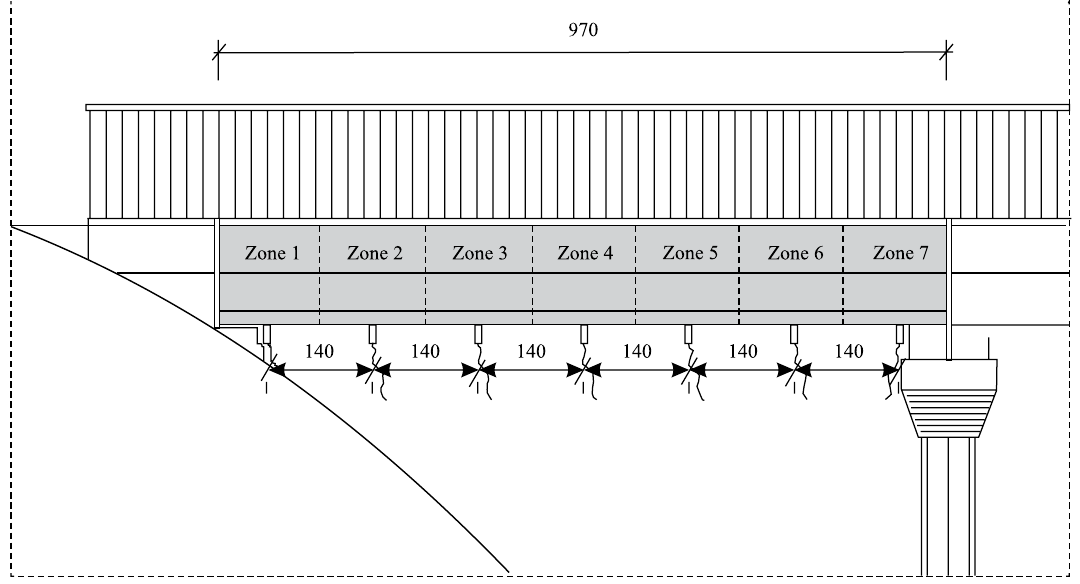
Fig. 6. The structure under consideration and arrangement of the AE sensors along one of the beams (measurements in cm)